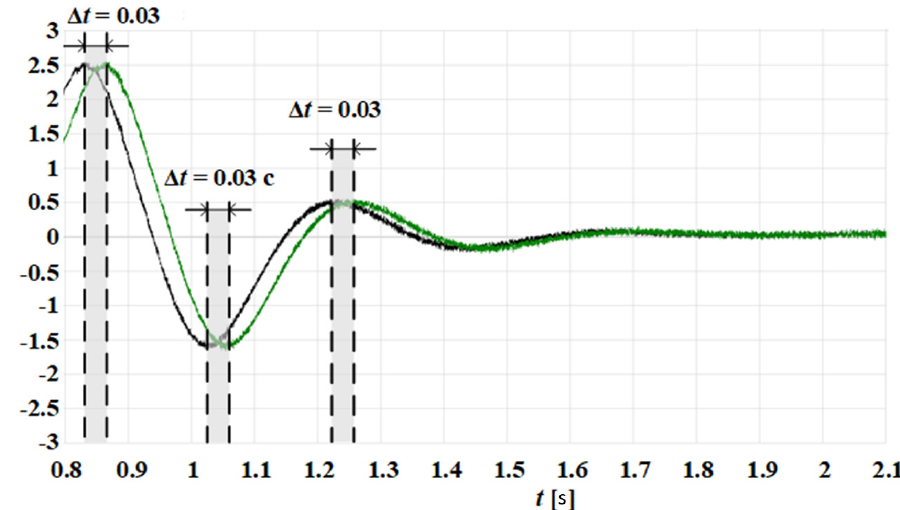
Figure 7. Oscillograms of signals obtained when testing the second ‐ order Padé function.